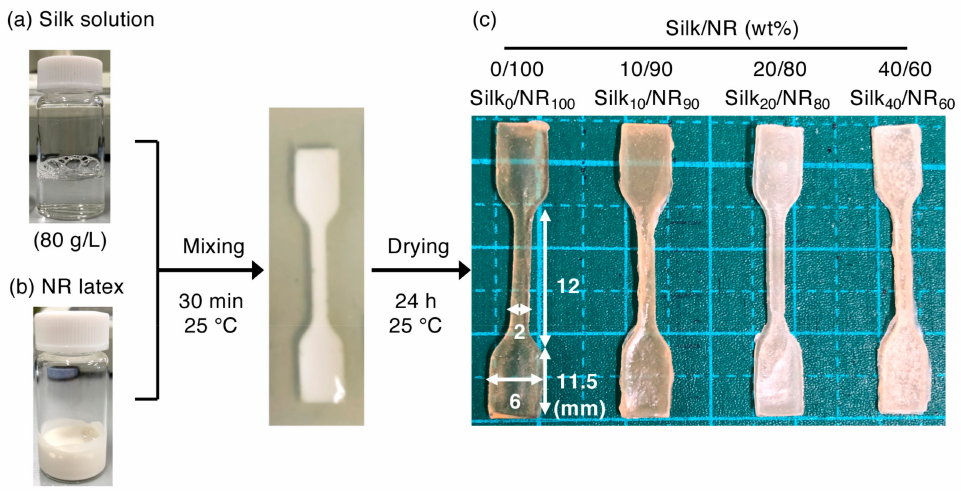
Figure 1. Sample preparation protocol of silk / NR composites and their appearance. Silk solution (80 g / L) ( a ) was mixed with NR latex ( b ) and stirred for 30 min at 25 ◦ C. The mixture was poured into a silicon mold and dried for 24 h at 25 ◦ C, to give silk / NR composites with di ff erent silk contents ( c ). The silk content was varied by changing the volume of silk solution, while keeping the other parameters